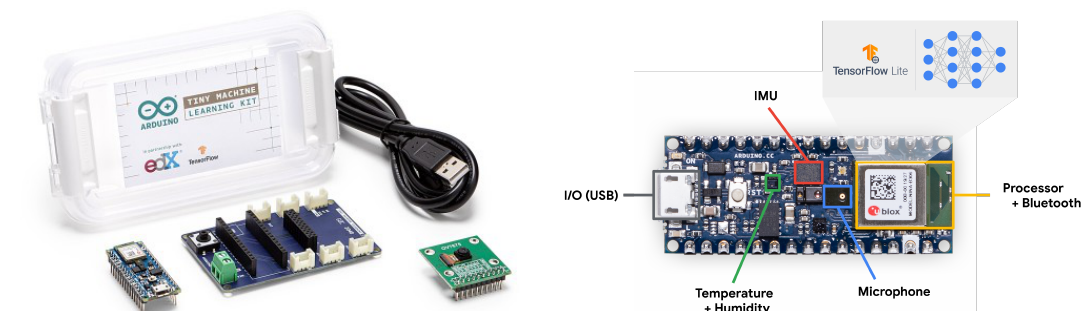
Figure 6. The Arudino TinyML Kit. Shown at left, the TinyML Kit includes the Arduino Nano 33 BLE Sense (Arduino, 2021a), an OV7675 camera module (ArduCam, 2021a), and a TinyML shield that simplifies sensor integration. Shown at right, the Nano 33 BLE includes a set of onboard integrated sensors (e.g., temperature/humidity, IMU, and microphone), a Bluetooth Low Energy (BLE) module, and an Arm Cortex-M microcontroller that can run neural-network models using TensorFlow Lite for